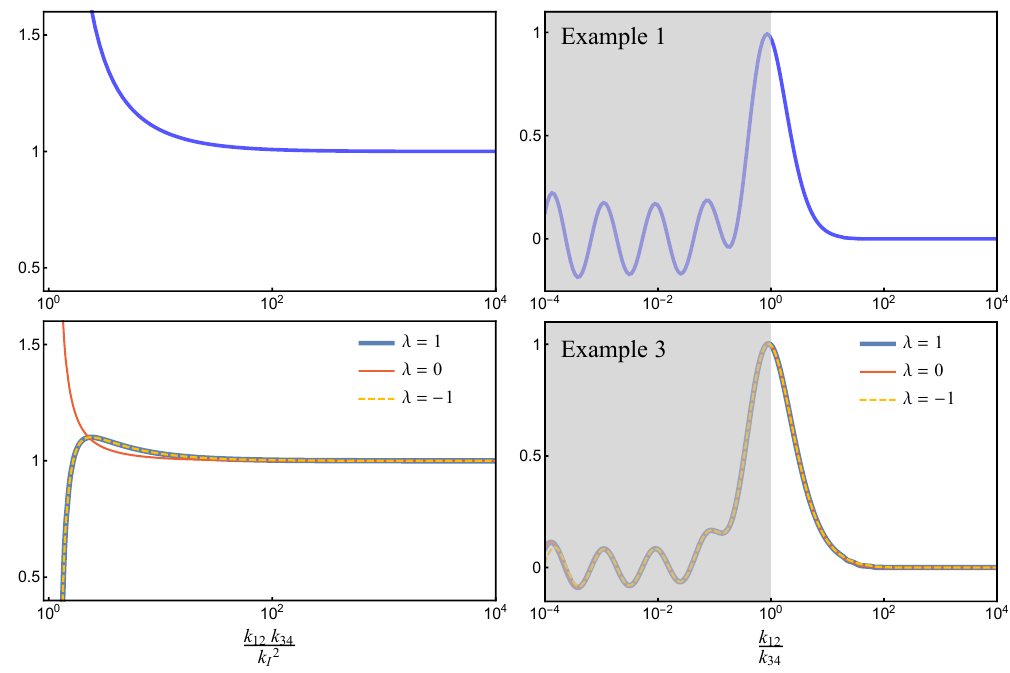
Figure 15 . The numerical result of the commutator integral I I,com . First row: the scalar exchange case in Example 1. Second row: the vector exchange case in Example 3 with chemical